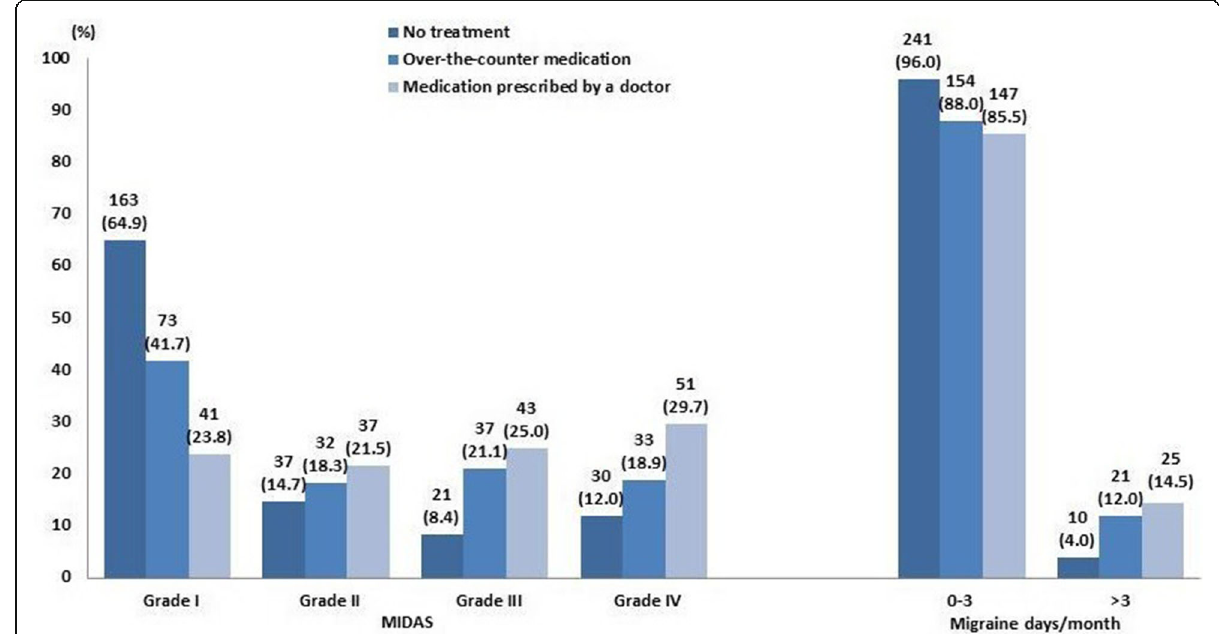
Fig. 4 Treatment seeking by migraine-related disability (MIDAS) and migraine days per